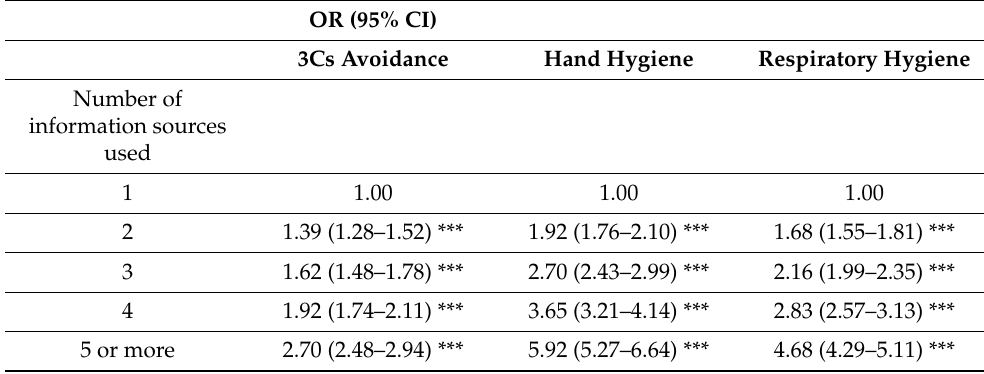
Table 3. Number of information sources used and adoption of preventive